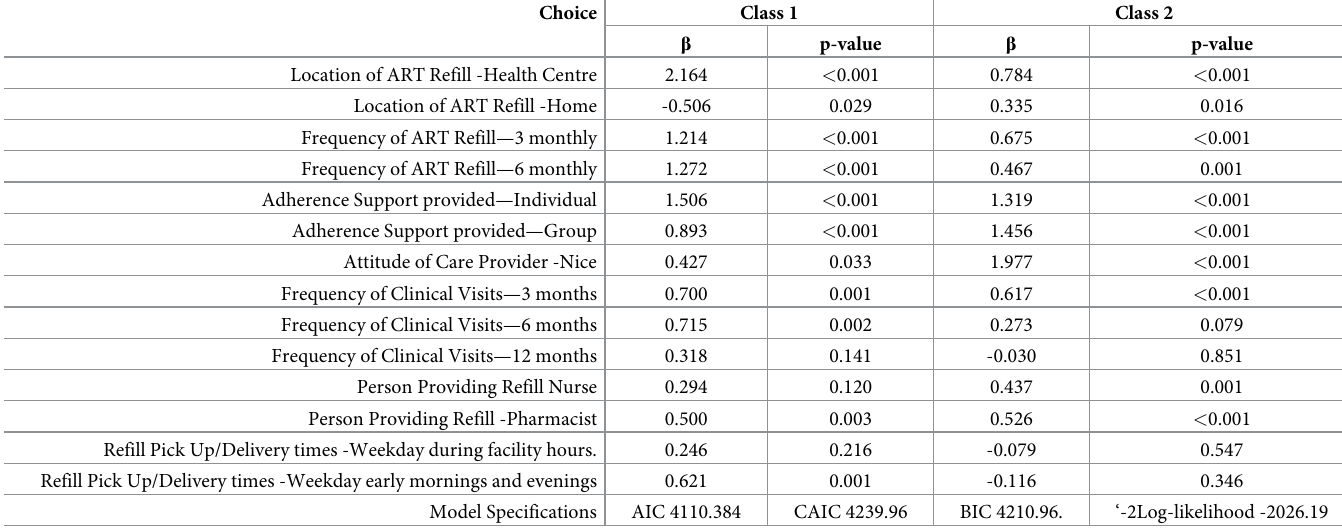
Table 5. Latent class analysis model for two classes with confidence